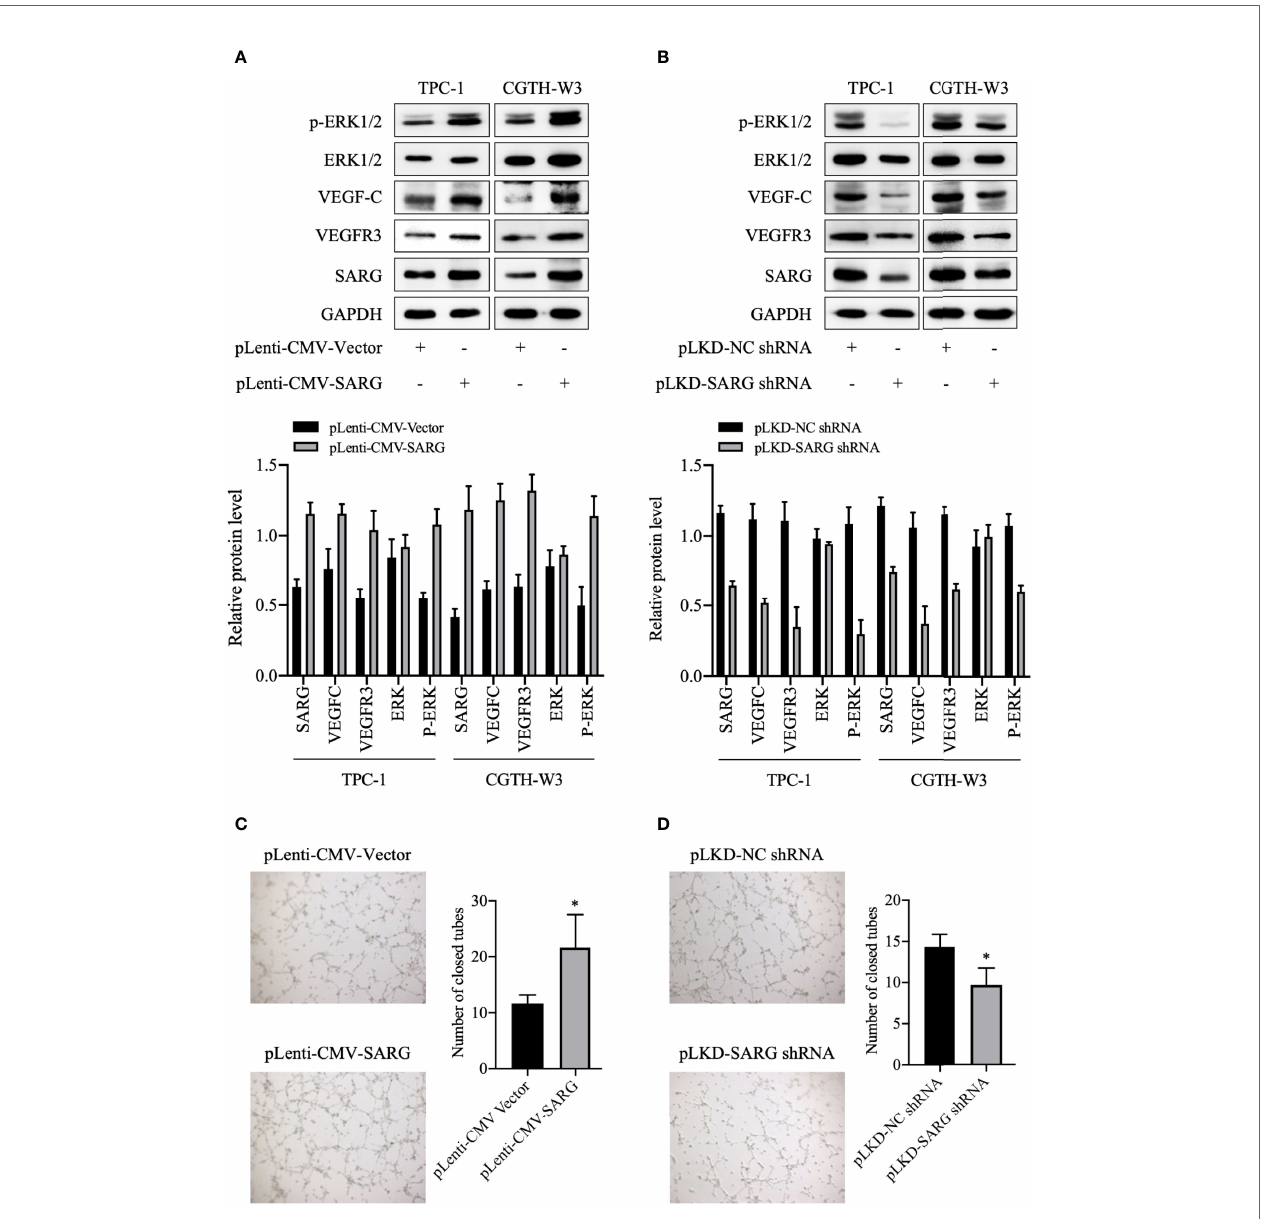
FIGURE 7 | SARG was involved in VEGFC/VEGFR3 regulation and HUVEC tube formation. (A, B) VEGF-C and VEGFR3 levels were analyzed by immunoblotting upon SARG overexpression or knockdown, with GAPDH used as the loading control. (C, D) The tube formation ability of HUVECs was detected by tube formation assay. * p<0.05 compared with NC-shRNA. SARG, speci fi cally androgen-regulated gene; VEGF-C, vascular endothelial growth factor C; VEGFR-3, vascular endothelial growth factor receptor